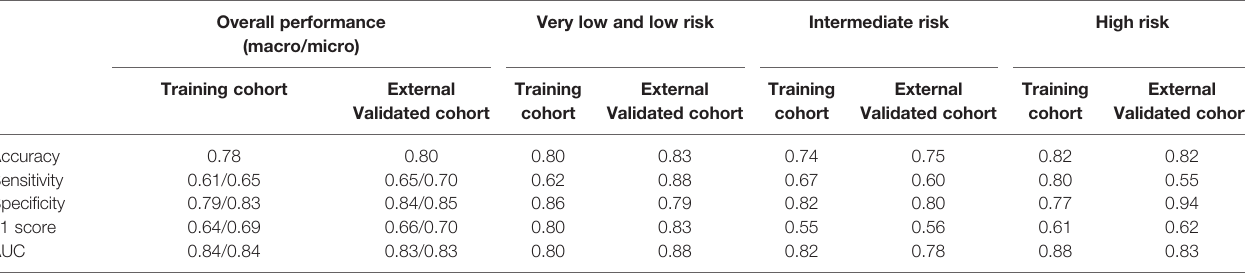
TABLE 3 | The predictive performance of radiomics model for discrimination of the three different risk degrees of GISTs.